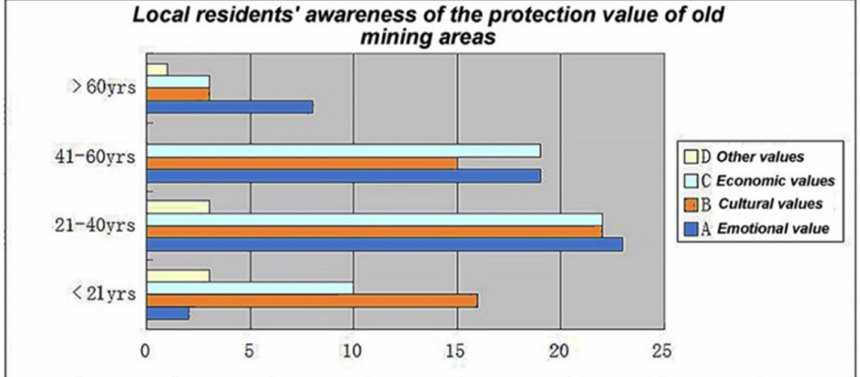
Figure 14. The value of old mines and equipment considered by residents.